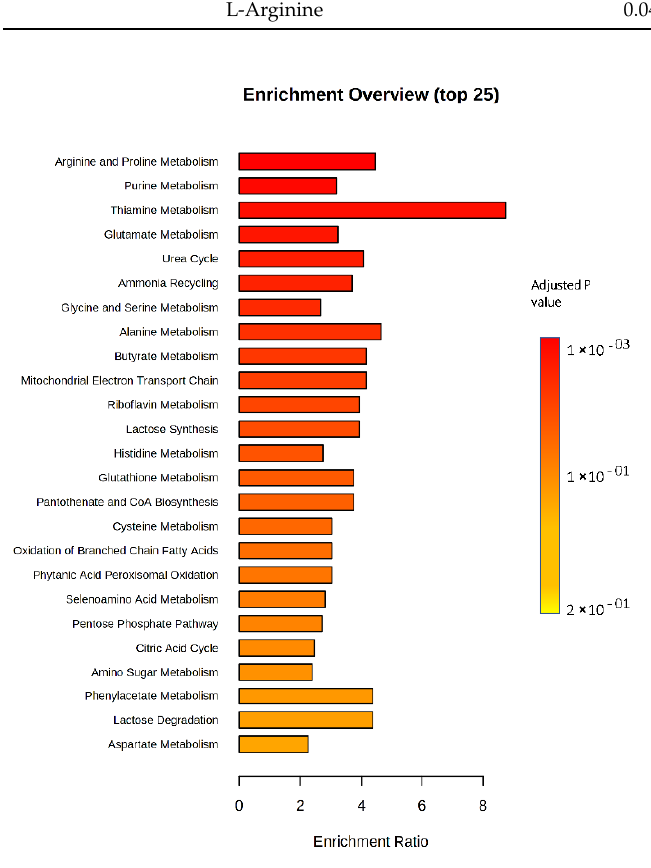
Figure 4. Metabolomic set functional analysis showing the most altered functional metabolic path- ways in resistant Hep3B cells. The graph was obtained using pathway enrichment analysis in the MetaboAnalyst software through plotting the p values on the